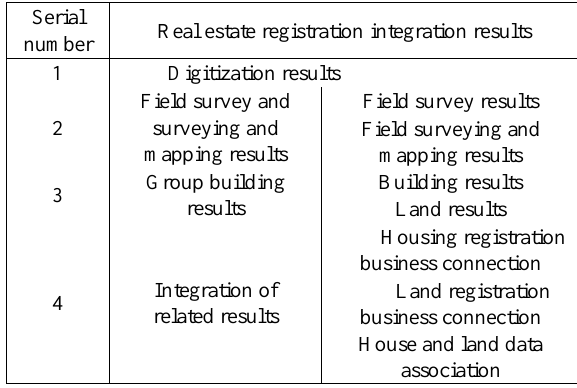
Table 1 . Real estate registration integration